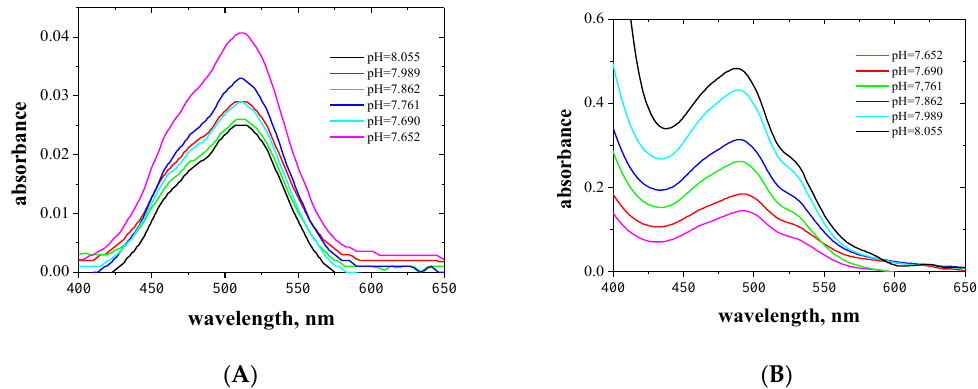
Figure 4. Absorption spectra of aqueous ( A ) and organic ( B ) phases after extraction of the Co(II) complexes with EDAB-acac in methylene chloride together with the corresponding pH of the aqueous phase.